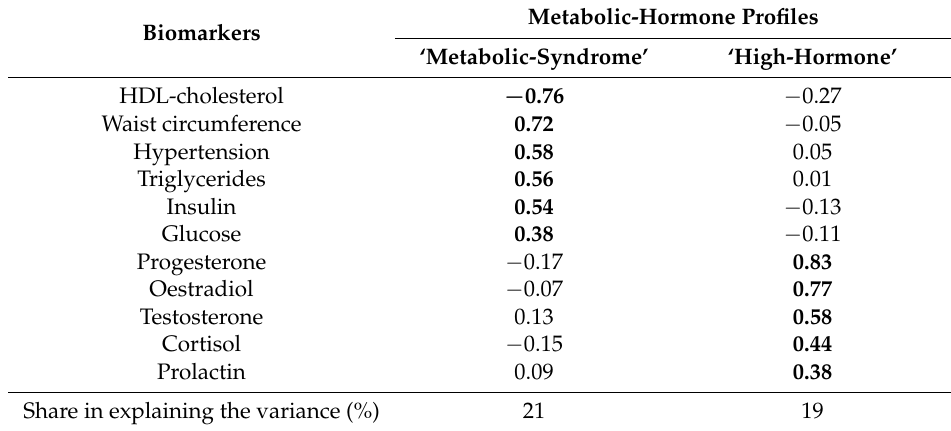
Table 4. Factor loadings for metabolic syndrome components and serum hormone concentration in PCA-derived profiles among post-menopausal women ( n = 129).